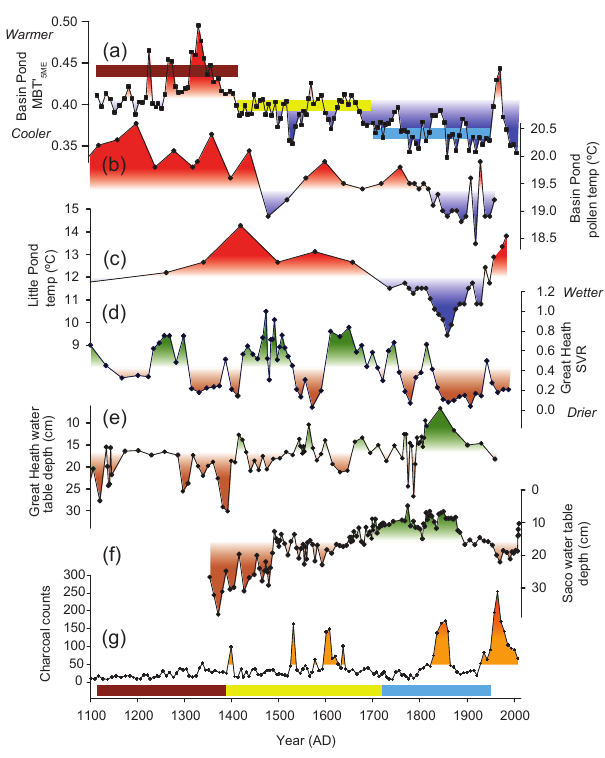
record compared with other Figure 9. The Basin Pond MBT (cid:48) 5ME paleoclimate records from the NE US. (a) MBT (cid:48) (this study). 5ME Colored bars indicate the three main periods discussed in the text. (b) Pollen-based reconstruction of temperature at Basin Pond (Gajewski, 1988). (c) Temperature reconstruction based on deu- terium isotopes ( δ D) at Little Pond (Gao et al., 2017). (d) Great Heath aridity reconstruction based on the Sphagnum / vascular ra- tio (SVR) (Nichols and Huang, 2012). (e) Water table reconstruc- tion from Great Heath (Clifford and Booth, 2013). (f) Water table reconstruction from Saco Bog (Clifford and Booth, 2013). (g) Char- coal counts from Basin Pond (Miller et al.,